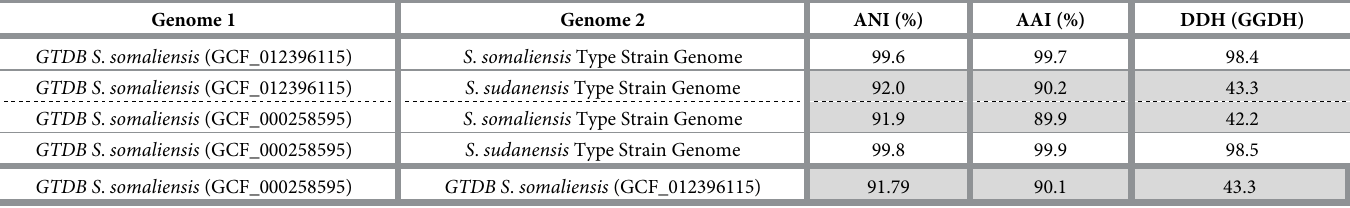
Table 1. Summarising the pairwise ANI, AAI and estimated DDH values of the S . somaliensis and S . sudanensis type strain genomes compared to genomes in GTDB. Species thresholds are usually defined by ANI > 95%, AAI > 95% and DDH > 70%. Values that fall below these thresholds are highlighted in grey. Results indicate that GTDB GCF_000258695 (annotated as S . somaliensis ) is most closely related to S . sudanensis , though it is a different